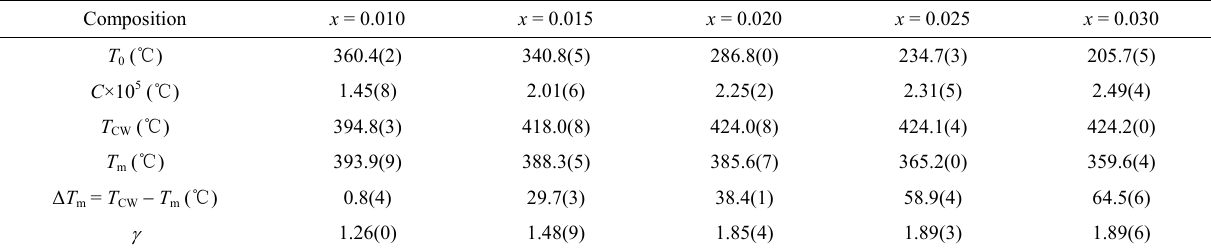
Table 2 Fitting parameters for (1 − x )KNN– x BZN ceramics with different BZN contents based on deviation degree